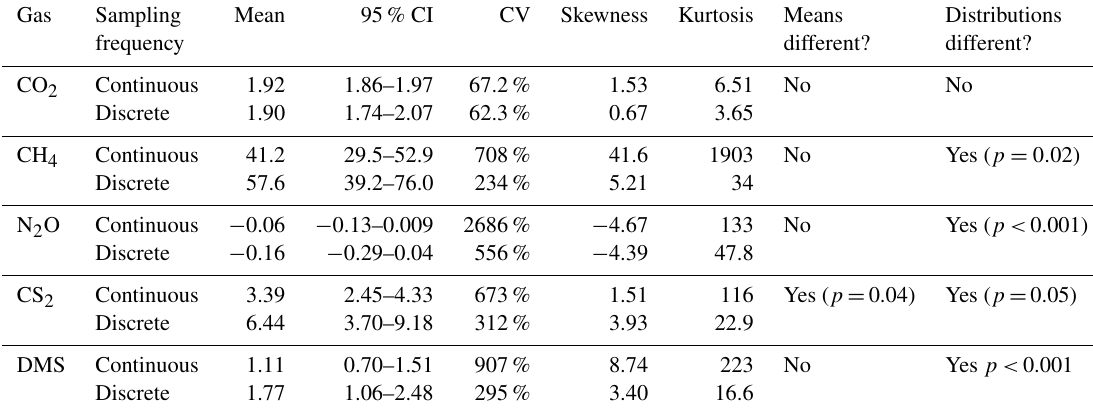
Table 1. Summary of continuous (over ∼ 72h) and discrete (one hour before and one hour after low tide) measurement data and distributions for each gas. An alpha of < 0.05 was used to determine significant differences between the means and the distributions. Note that the means for CO 2 are inµmolm − 2 s − 1 , while the other gases are in nmolm − 2 s − 1 . Gas Sampling Mean 95% CI CV Skewness